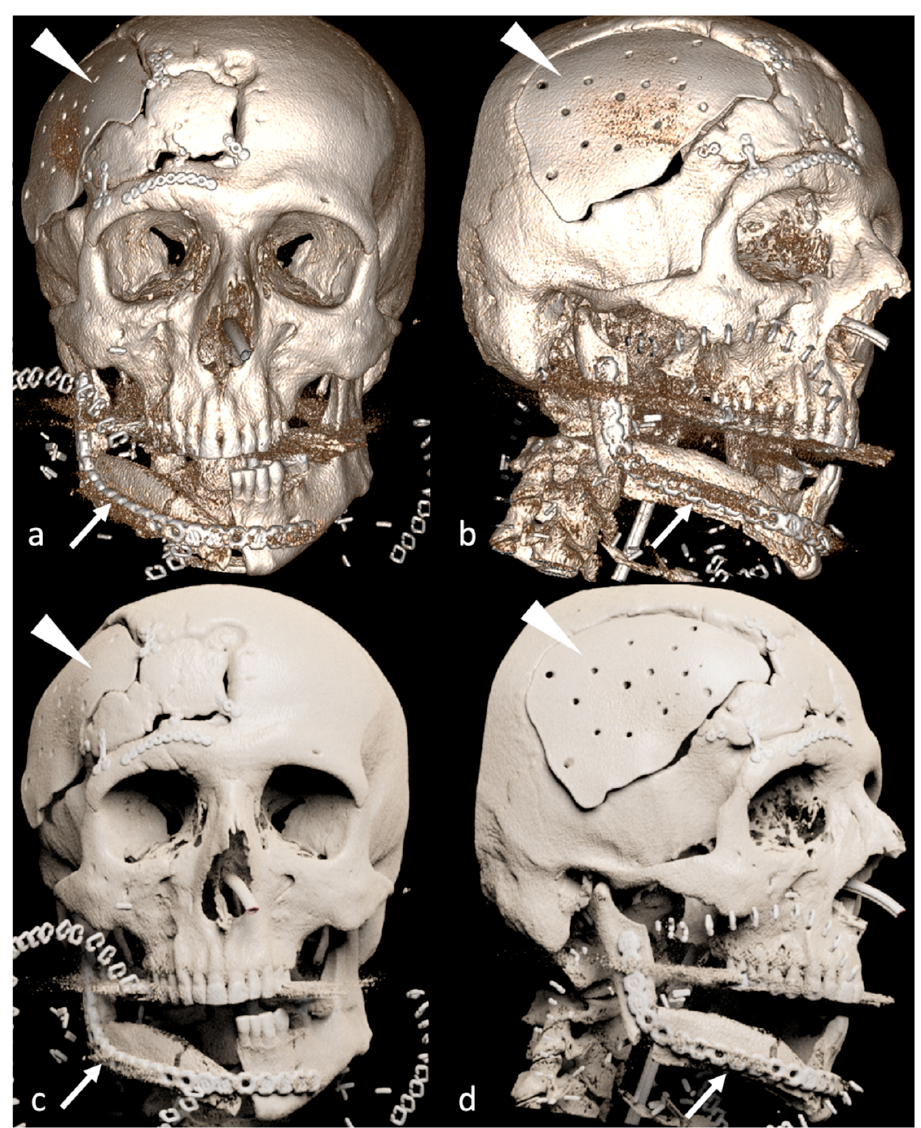
Figure 2. VR ( a , b ) and PT ( c , d ) reconstruction of scapular bone flap (arrows). The major depth of field and the better handling of metal artefacts of PT reconstructions are the key factors for better understanding post-surgery imaging compared to VR reconstructions. The patient underwent previous cranial vault surgery for trauma (arrowheads).